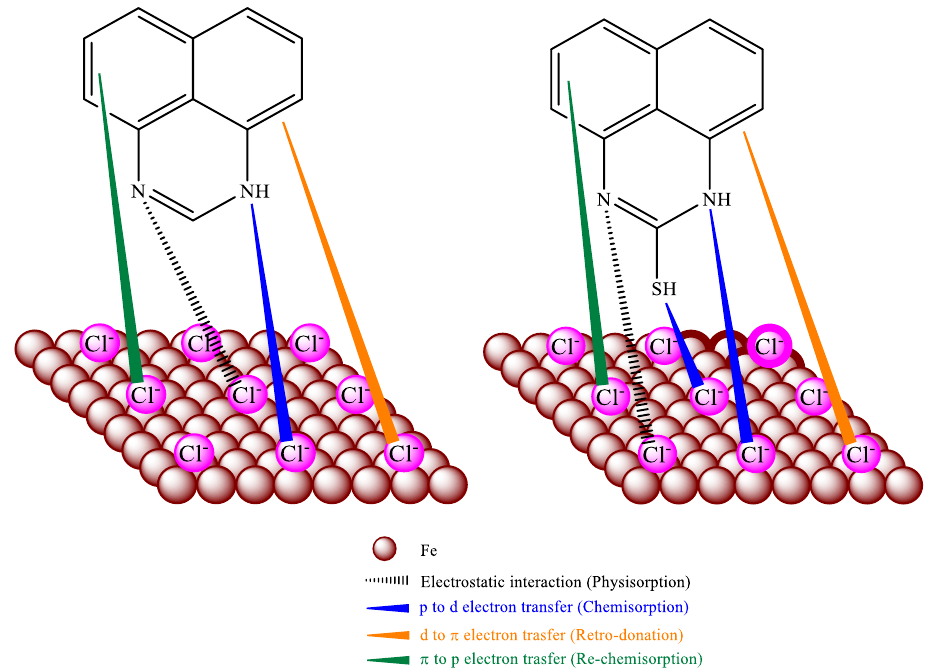
Figure 9. Inhibition and adsorption mechanisms of PMD and SPMD.